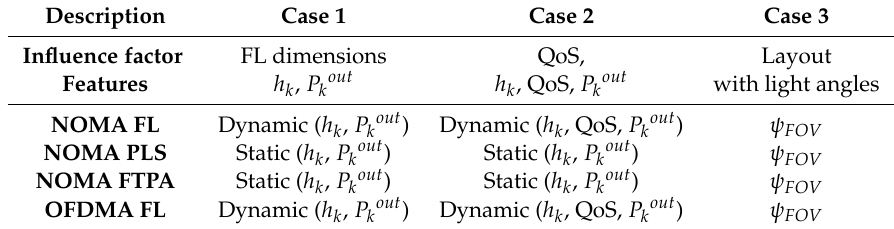
Table 4. Comparisons of different cases. The labels FL, FOV, FTPA, NOMA, OFDMA, PLS, and QoS are fuzzy logic, field of vision, fractional transmit power allocation, non-orthogonal multiple access, orthogonal frequency division multiple access, power law strategy, and quality of service, respectively. Description Case 1 Case